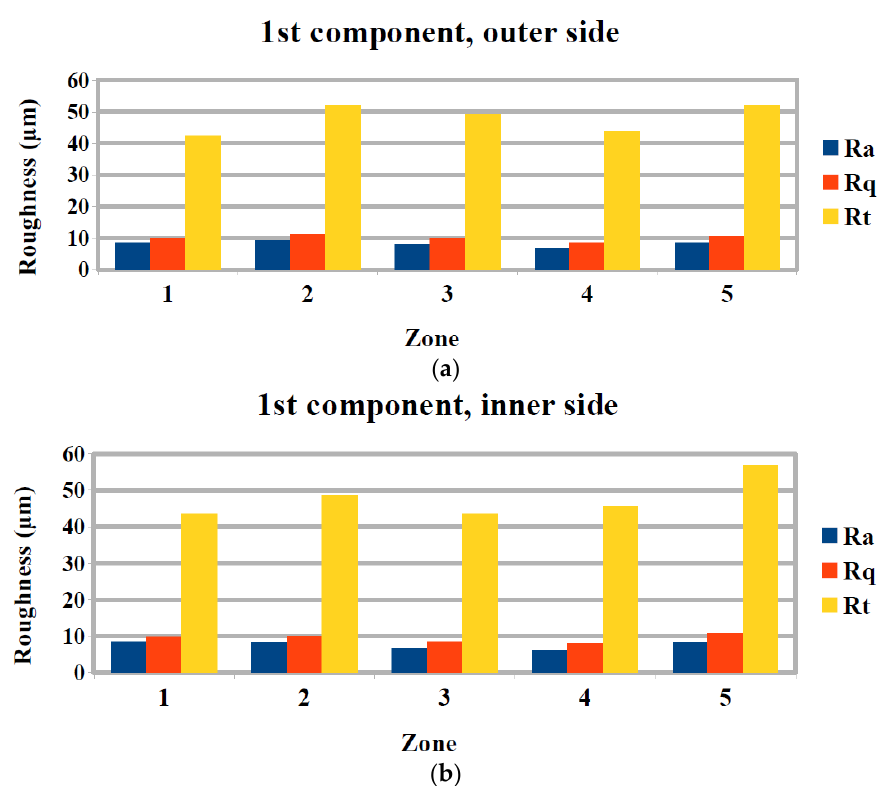
Figure 10. Surface roughness measurement results for the first femoral component for ( a ) outer and ( b ) inner side.